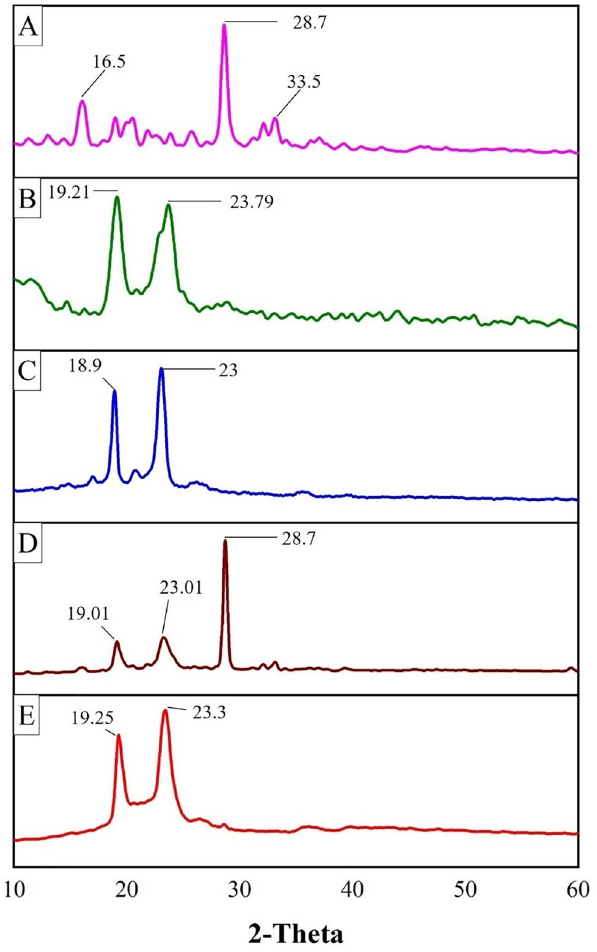
Fig 3. p XRD analysis of 5-FU (A), Precirol 1 ATO5 (B), Poloxamer 188 (C), Physical mixture (D), and optimized formulation